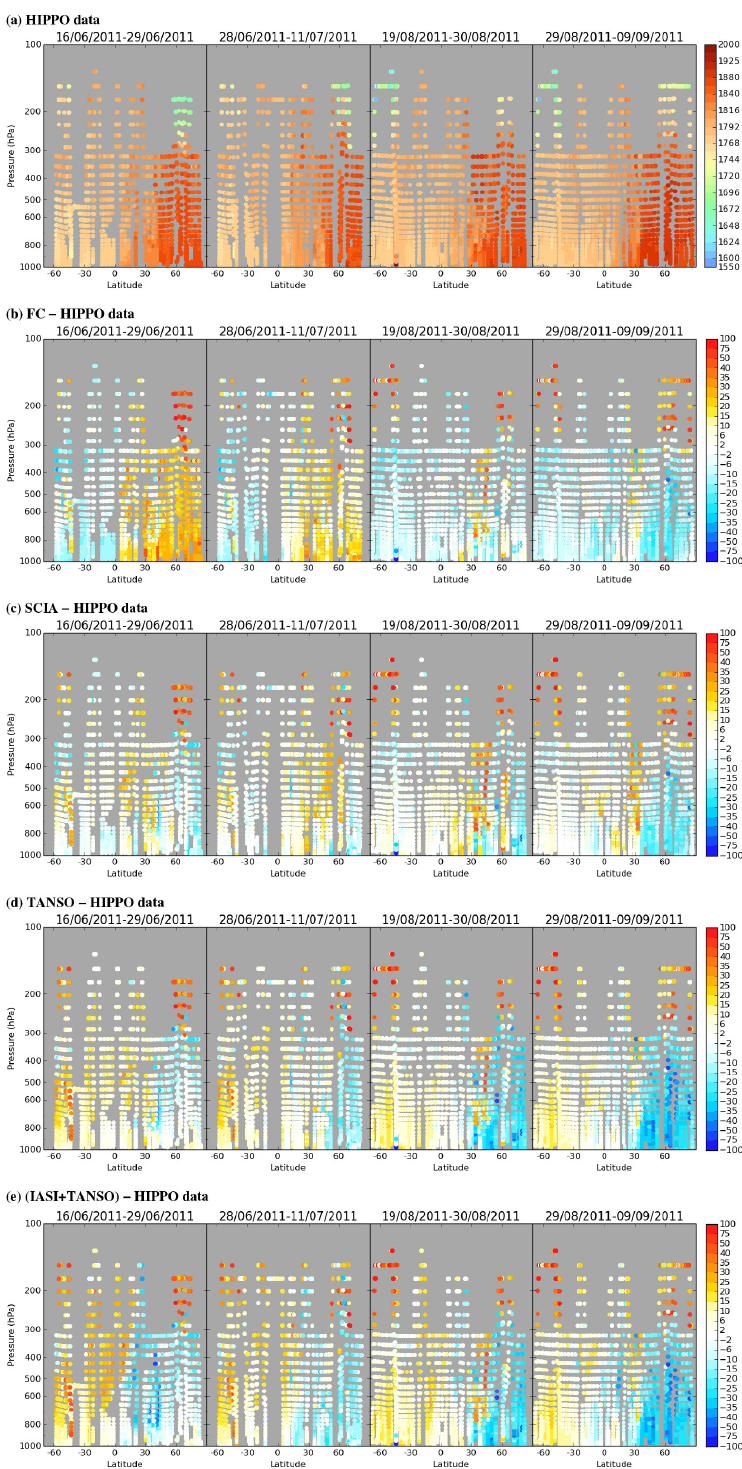
Figure 9. Top row (a) : HIPPO CH 4 data (latitude vs. pressure, in ppb) for the four campaigns (from the leftmost panel for the first campaign to the rightmost panel for the last campaign). The beginning and end dates of each campaign are detailed on top of each panel. From rows 2 to 5: difference between the experiments and the HIPPO data (in ppb): (b) FREE minus HIPPO, (c) SCIA analysis minus HIPPO, (d) TANSO (v.1) analysis minus HIPPO and (e) TANSO+IASI analysis minus HIPPO. A global bias has been removed from the FREE run and from each analysis (see Table 1). The grey shade means there is no